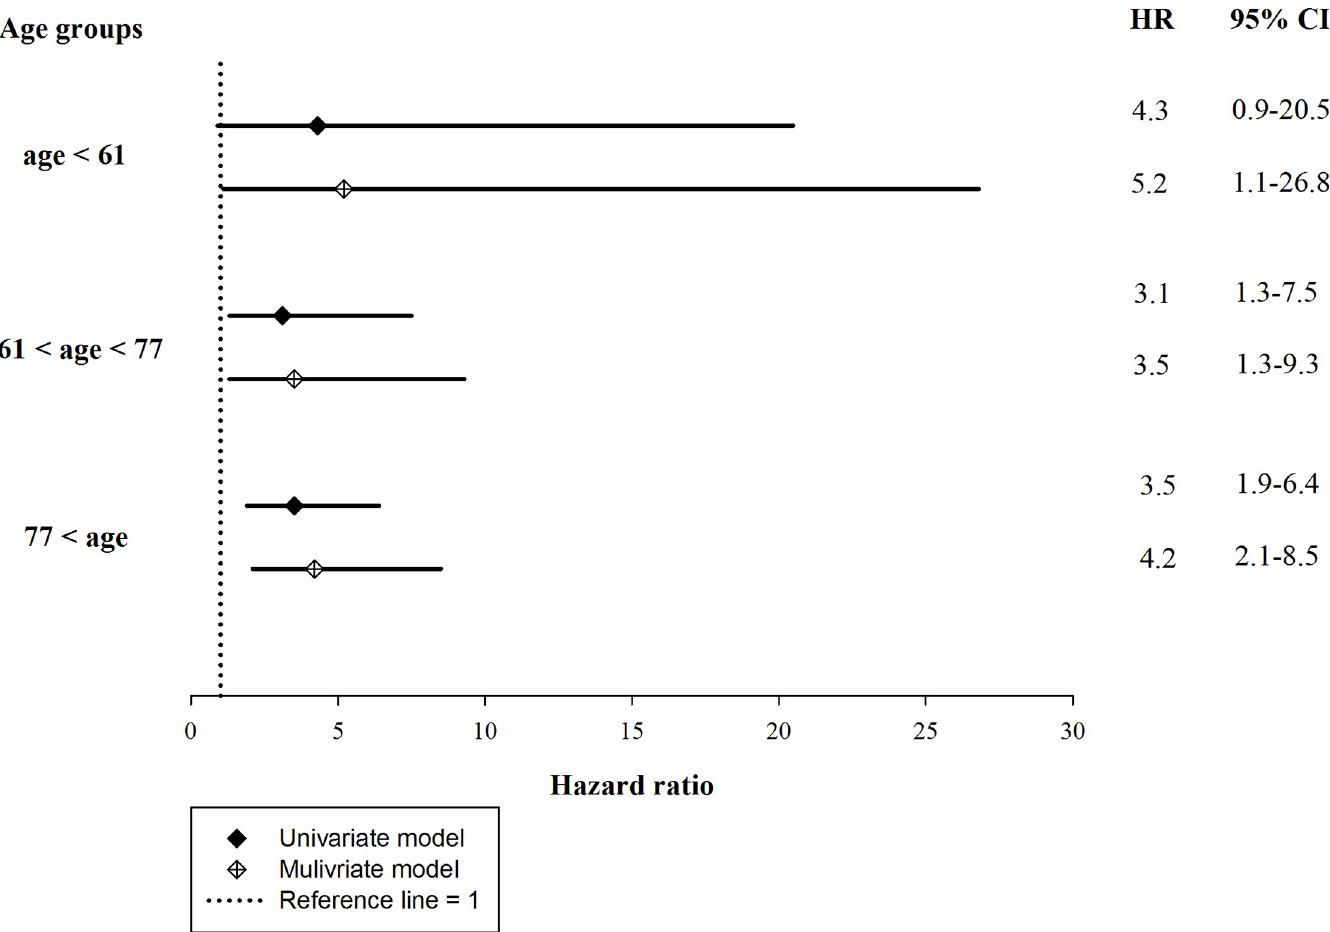
Fig 3. Survival probability of incident ESRD patients stratified by the presence of AF. By Kaplan-Meier method. ESRD, end-stage renal disease; AF, atrial fibrillation.